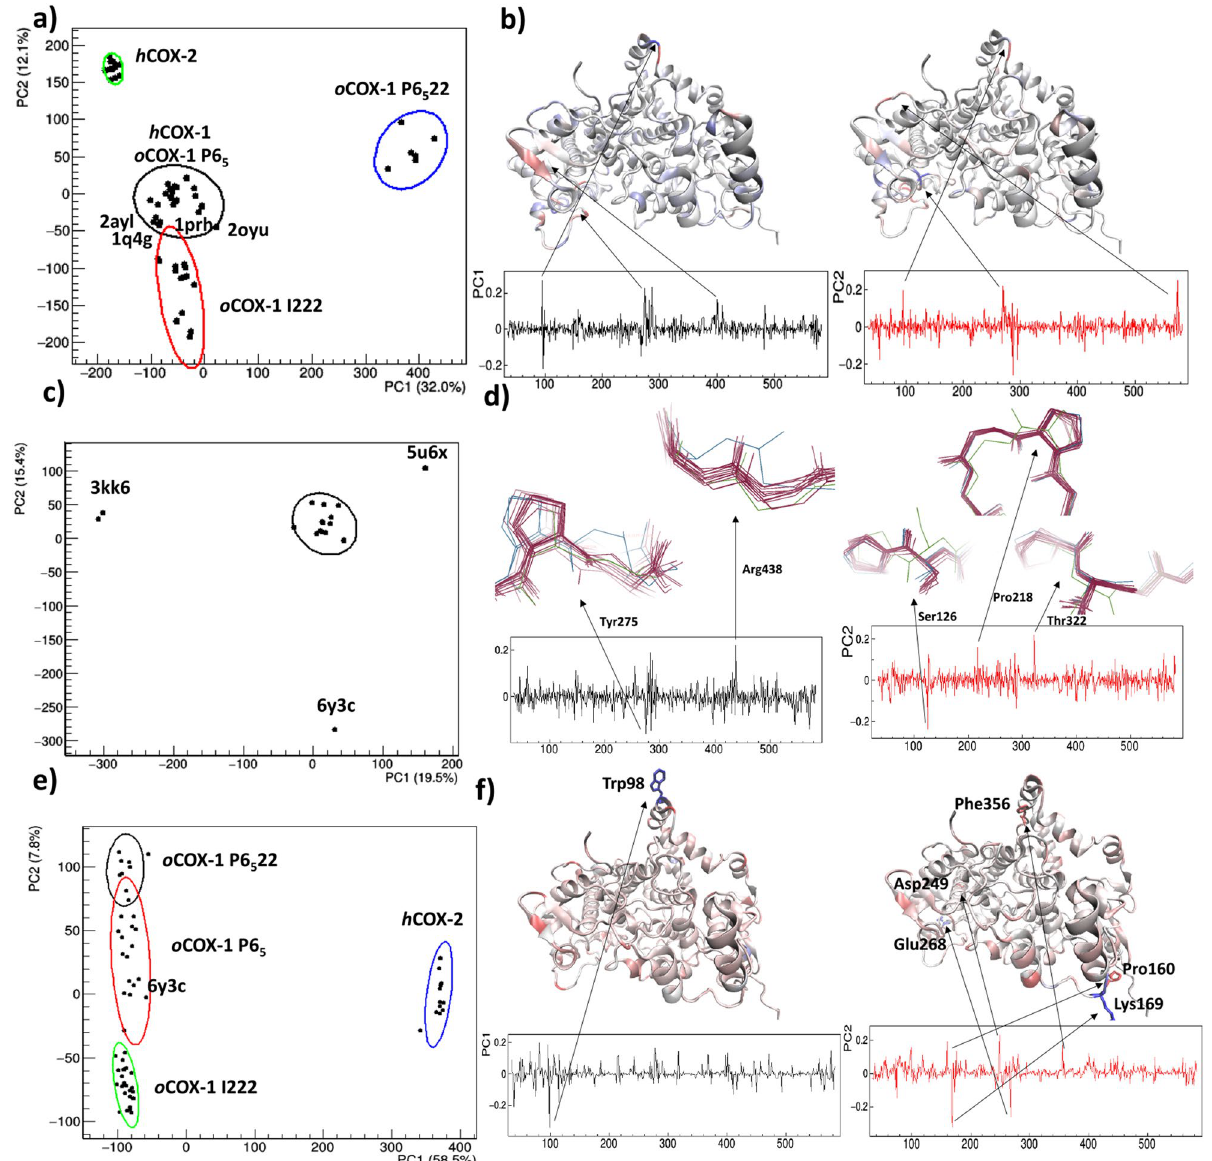
Figure 8. Comparison of h COX-1, o COX-1, and h COX-2 structural models by principal component analysis applied on PAV ( a – d ) and SASA ( e , f ) profiles. A restricted number of COX-1 structural models is considered in ( c , d ). [On the left is shown the score plot of the first two principal components, where representative points are grouped according to a hierarchic clustering algorithm. 85% confidence level ellipses are shown, and PDB codes associated with representative points are reported. The percentage of the total data variance explained by each principal component is shown on the axes. On the right are shown the loadings of the first (black) and second (red) principal components, the structural model 6Y3C colored according to the loading values, from red for higher positive to blue for higher negative ( b , f ), and the superposed structural models with 6Y3C and 3KK6 colored respectively in green and blue ( d ). Arrows point to protein residues having the highest and lowest loadings values. Residues falling in these regions are drawn in “bonds” representation in ( f